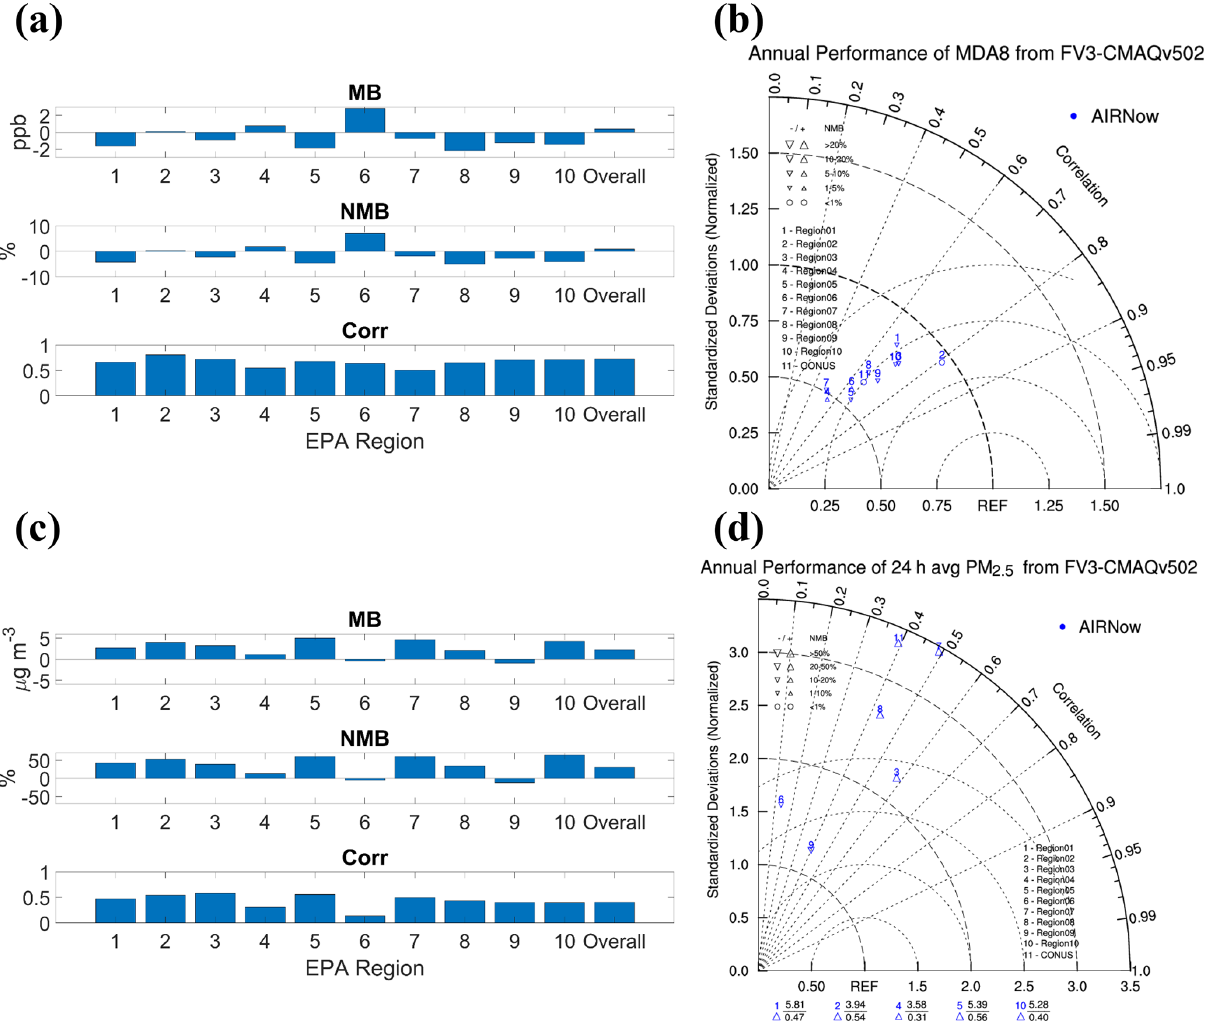
Figure 6. Annual performance of MDA8 in 10 CONUS regions (a) ; Taylor diagram for annual performance of MDA8 (b) ; annual perfor- mance of 24h average PM 2 . 5 in 10 CONUS regions (c) ; Taylor diagram for annual performance of 24h average PM 2 . 5 . Outliers represent regions with NSDs > 3 . 5 (d)